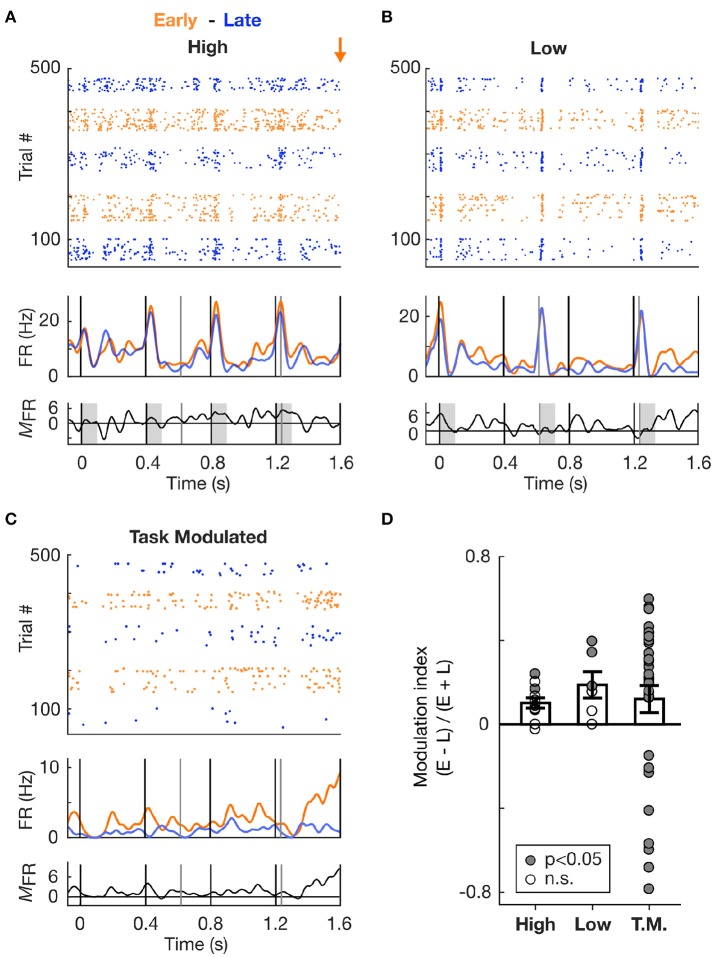
Increase in spiking activity prior to target occurrence irrespective of frequency tuning. (A) Increase in spiking activity in Early vs. Late trials for an example cell tuned to the High frequency sound. Top and second panels: Raster plots and corresponding mean PSTHs of spiking activity during Hit trials in S2 condition, color-coded based on block type (Early or Late). The time axis is truncated so as to encompass only the Early zone (EZ; 0–1.6 s from trial onset). The orange arrow marks the onset time of the first target in the Early block. The vertical lines indicate tone onset (black: High frequency, grey: Low frequency). Third panel: Firing rate modulation (measured as the difference) between the Early and Late PSTHs. Values above zero indicate an increase in firing rate in the Early vs. Late condition. (B) Same as in (A), but for a cell tuned to the Low frequency. (C) Same as in (A), but for a cell classed as Task Modulated (T.M.). (D) Modulation of the firing rate between Early and Late conditions, displayed for each cell type. A value above 0 indicates an increase in the Early vs. Late trials. Each dot represents a cell, and the dot is filled with grey color if the firing rate of the cell significantly differed in Early vs. Late condition.